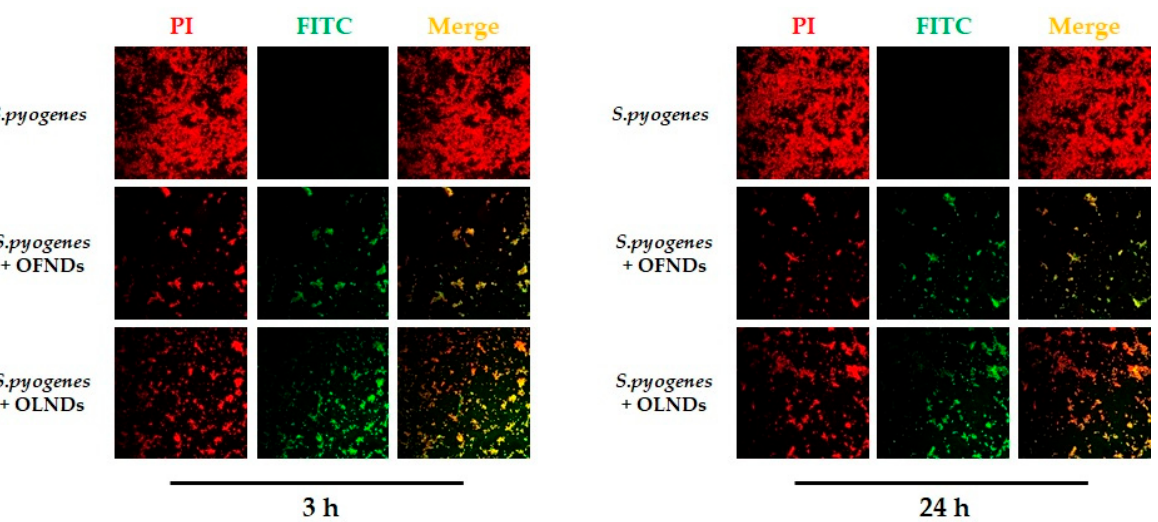
Figure 4. Representative confocal microscopy images of ND internalization by S. pyogenes after 3 and 24 h of incubation. Data are shown as representative images from three independent experiments. Red: PI. Green: FITC. Magnification: 100×.